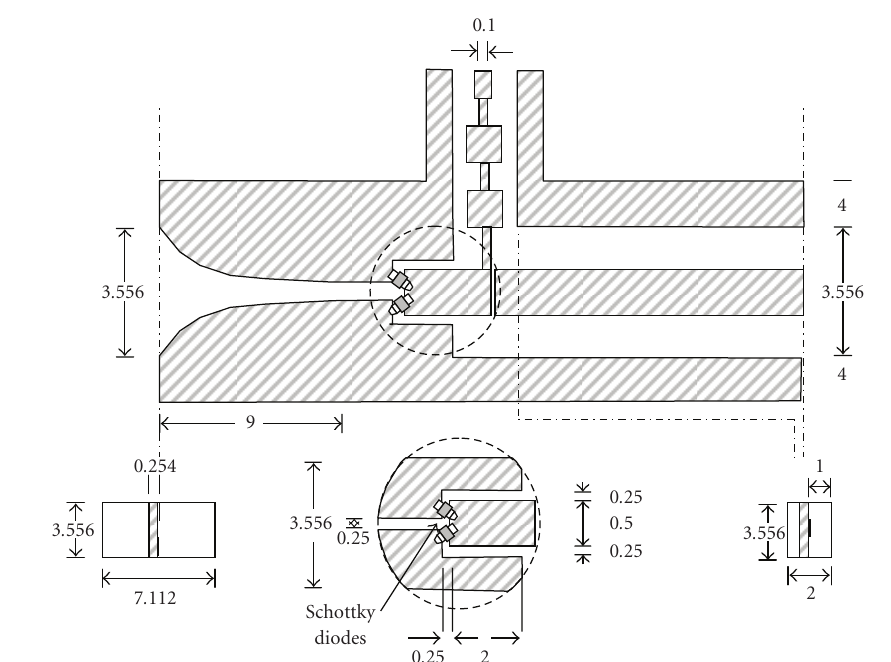
Figure 3: Layout and circuit details of the balanced BPSK modulator.